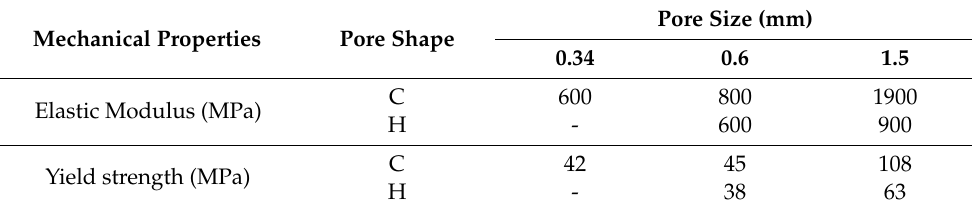
Figure 12. Stress–strain curves of the PolyJet and µ SLA 3D-printed scaffold structures at 30% porosity: ( a ) cubic pore shape; ( b ) hexagonal closed packed pore shape. Table 6. Mechanical properties of µ SLA 3D-printed scaffold